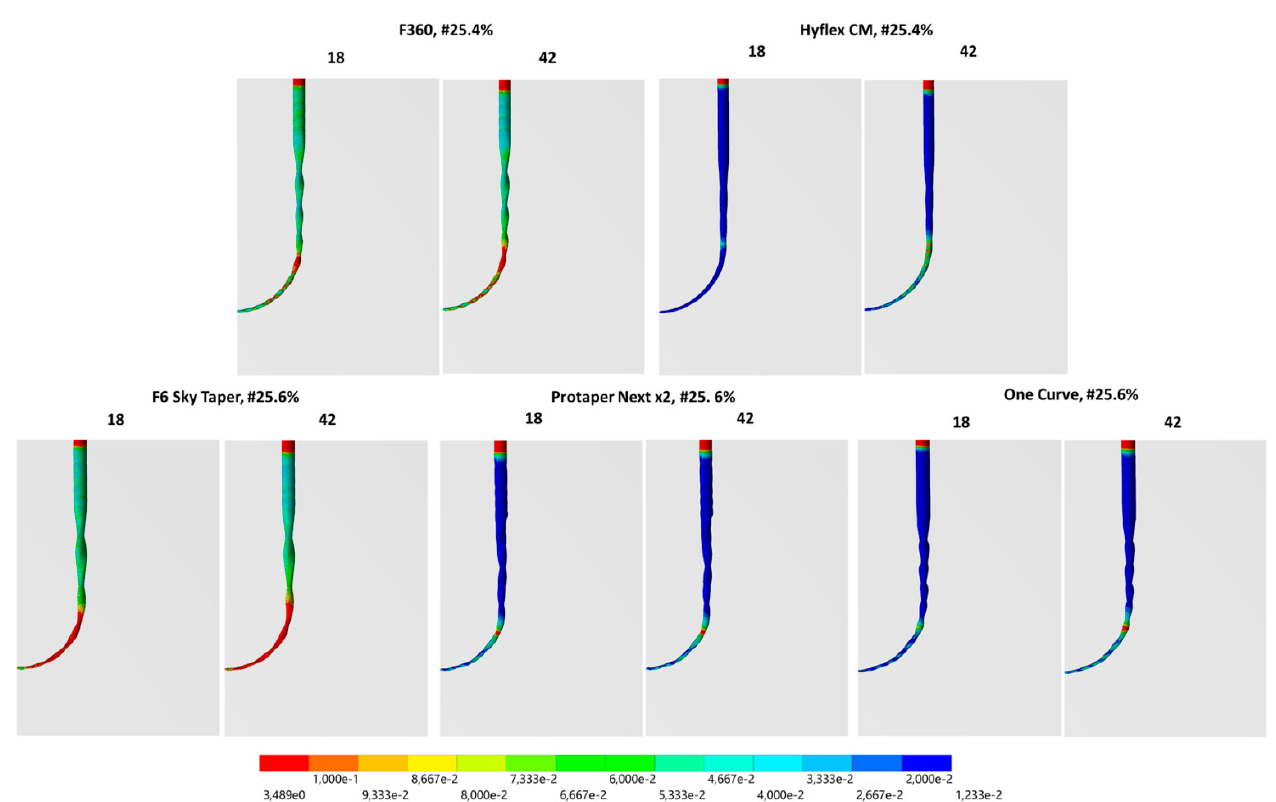
Figure 5. Von Mises stress distribution for each instrument according to the elastic modulus of the root canal (18 or 42 GPa).